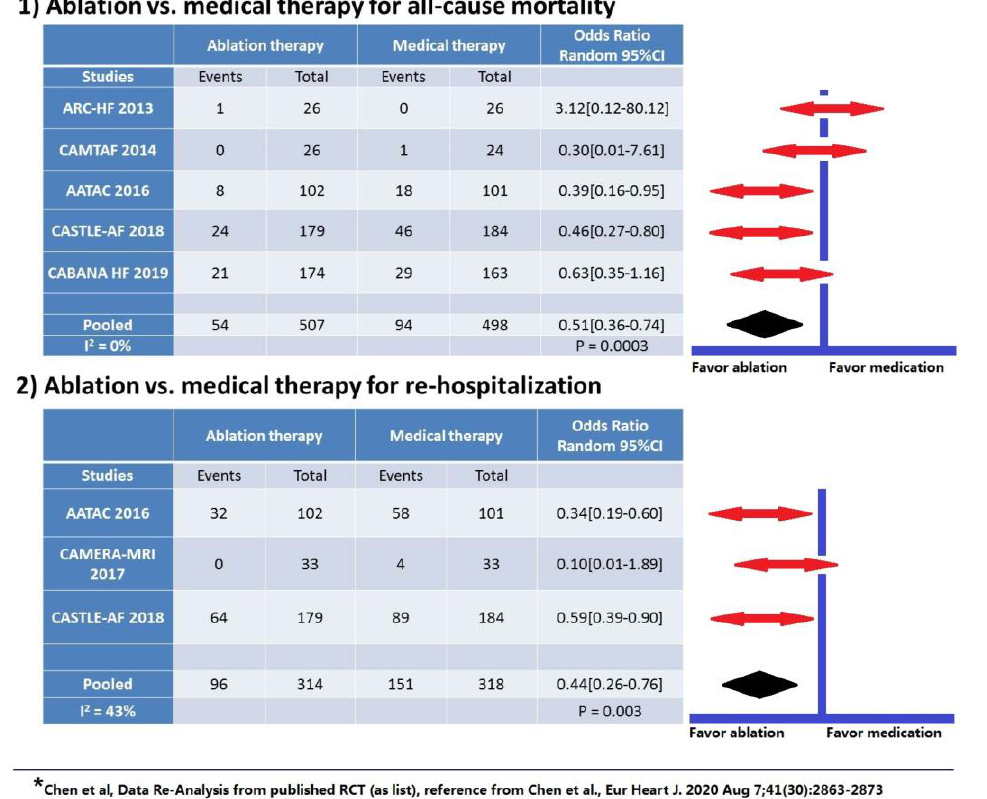
Figure 1. Catheter Ablation Rhythm Control vs. Medical Therapy: ( 1 ) Catheter ablation rhythm control vs. medical therapy for all-cause mortality; ( 2 ) Catheter ablation rhythm control vs. medical therapy for rehospitalization. Only a composite endpoint (including death, disabling stroke, serious bleeding, or cardiac arrest) was available in the CABANA HF subgroup.